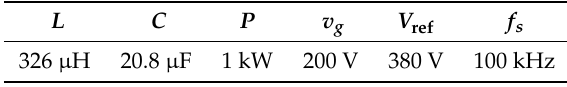
Table 1. The used parameter values for the system.